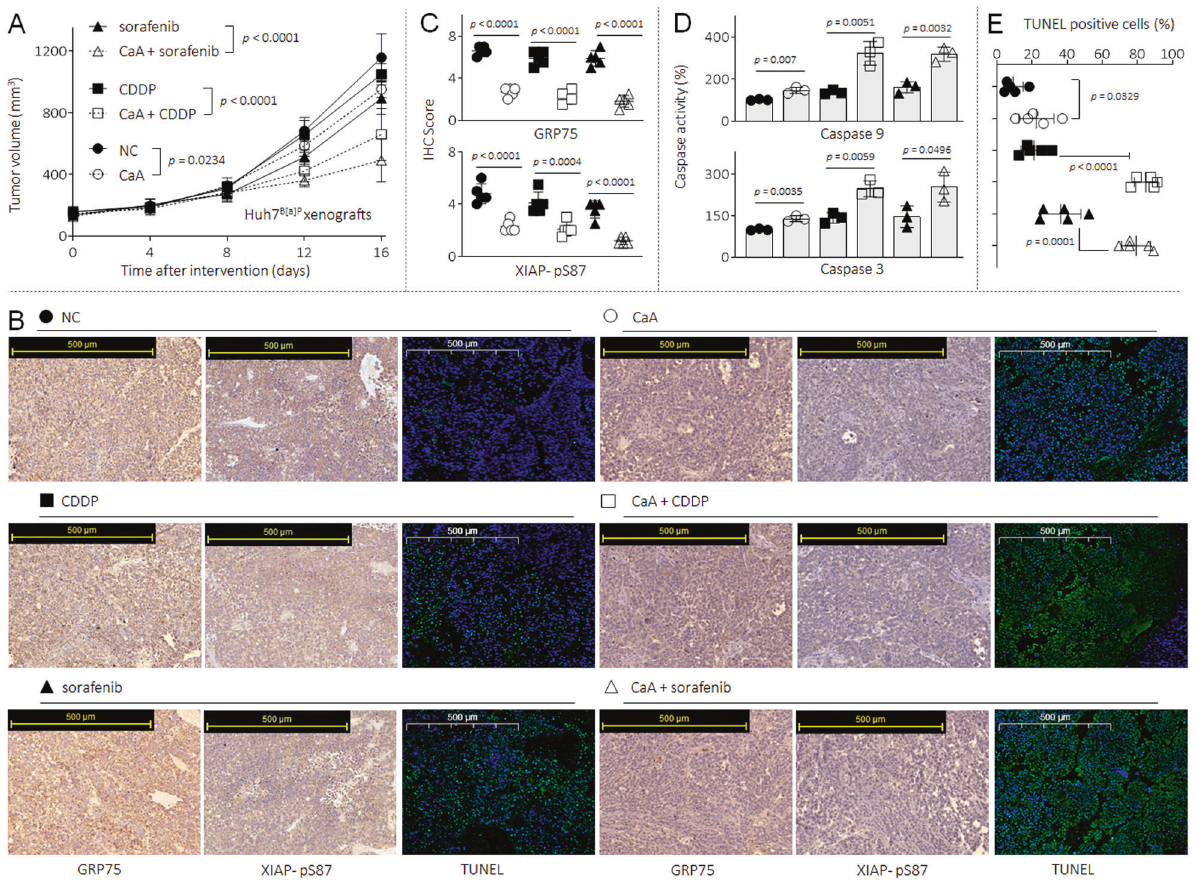
Fig. 7 Veri fi cation of the results in vivo. The HuH7 B[a]P cell xenografts were treated with CaA, CDDP or sorafenib alone, or treated with CaA combined with CDDP or sorafenib. A The volumes of xenografts tumors. B and C IHC staining of the GRP75 and XIAP (p-Ser87). D Relative caspase-9/3 activities in the xenografts tissues. B and E TUNEL staining and quantitative